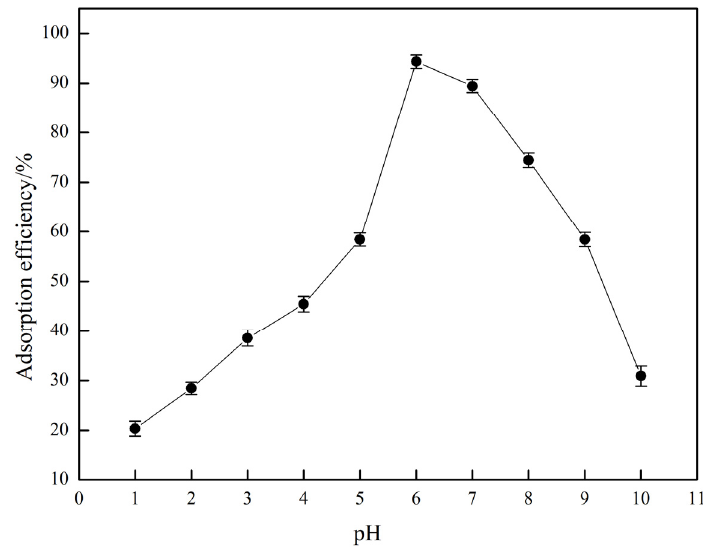
Figure 4. Effect of pH on the adsorption efficiency.